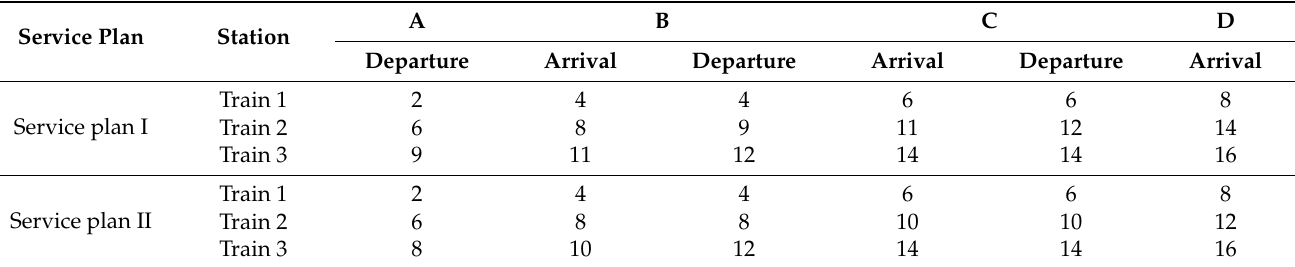
Figure 2. Two types of service plans with the same passenger demand. Table 3. Timetables of the two service plans.